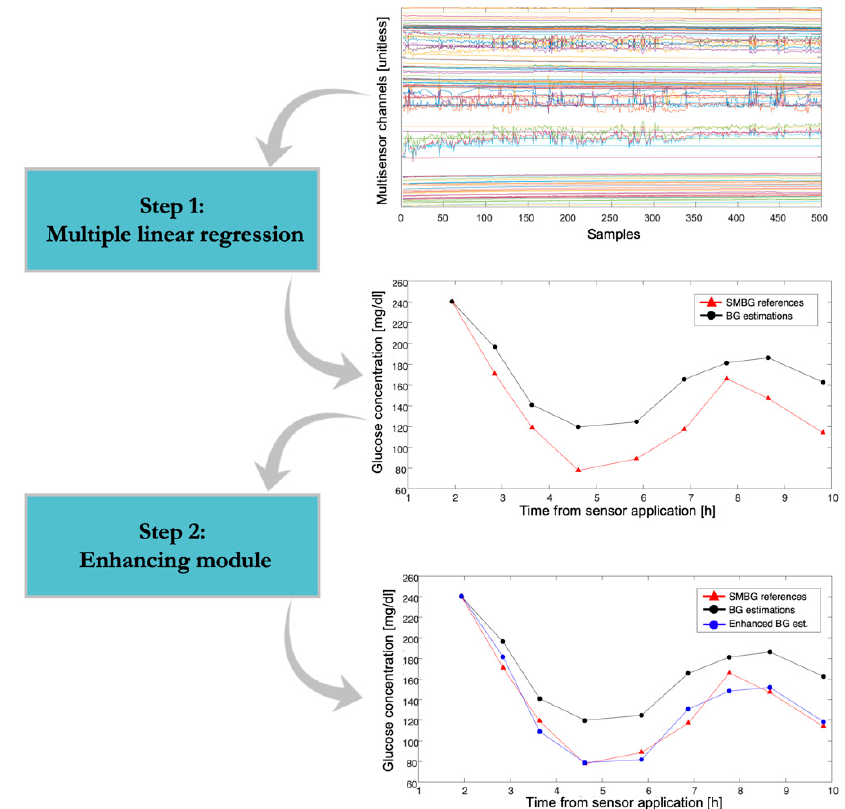
Figure 3. Schematic representation of the two-step procedure used to estimate the blood glucose (BG) time-series from the Multisensor measurements (real data from one representative subject). From top to bottom: raw Multisensor measurements, converted by the multiple linear regression (step 1) into a BG estimate (black curve, vs. reference measurements, red curve), further converted by the enhancing module (step 2) to enhanced BG estimate (blue curve, vs. BG estimate, black curve, vs. BG reference, red curve).